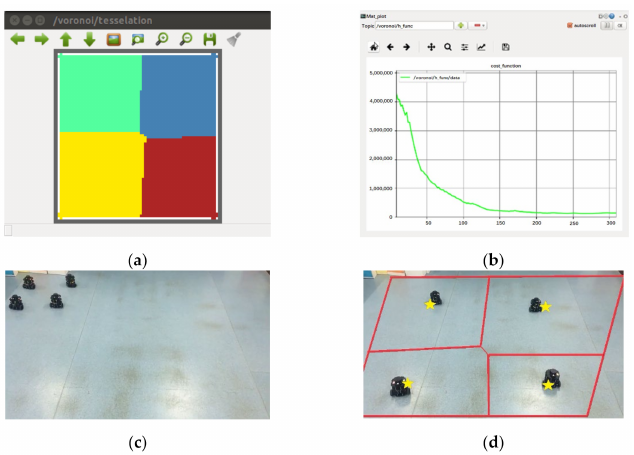
Figure 17. Square formation experiment: ( a ) density function distribution; ( b ) cost function; ( c ) initial position; ( d ) final